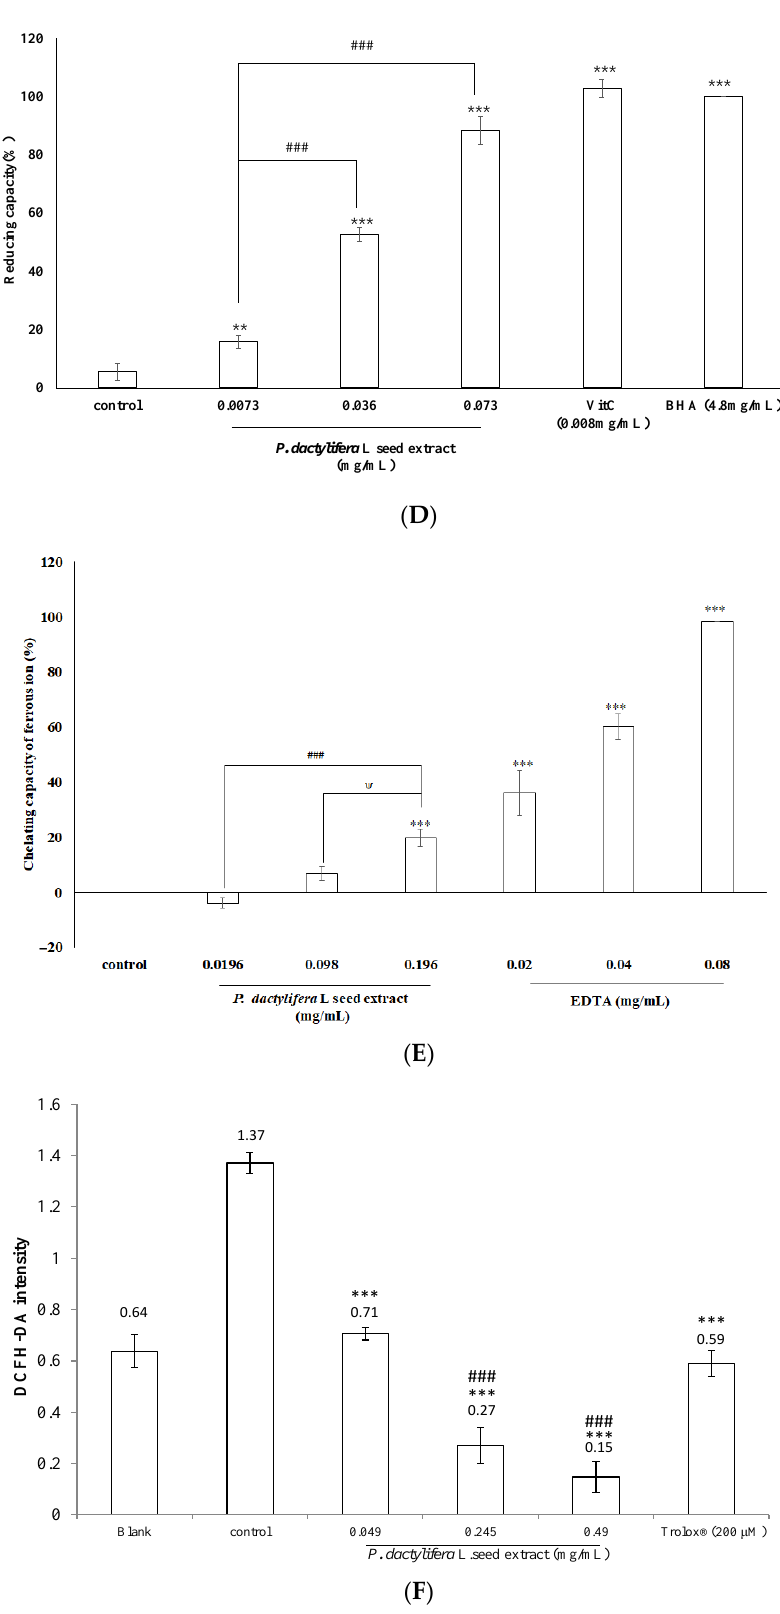
Figure 2. Antioxidant characteristics of P. dactylifera L. seed extract. ( A ) DPPH assay. The extract at various concentrations (0.0049, 0.0245, and 0.049 mg / mL), vitamin C (0.53 mg / mL), or BHA (0.1 mg / mL) interacted with DPPH. The control was DPPH only. ( B ) ABTS + assay. The ABTS + scavenging capacity of the extract (0.0098, 0.049, and 0.098 mg / mL) was compared with those of vitamin C (0.9 mg / mL) and BHA (0.9 mg / mL). ( C ) Total phenolic content assay. Di ff erent concentrations of extracts were